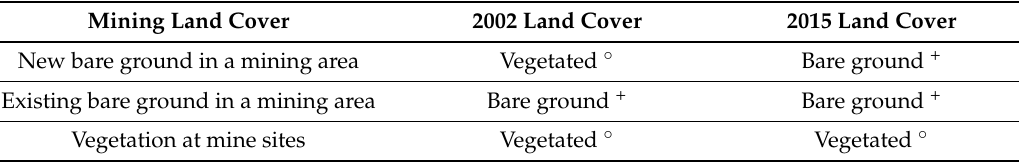
Table 2. Types of land cover identified for the mining area change